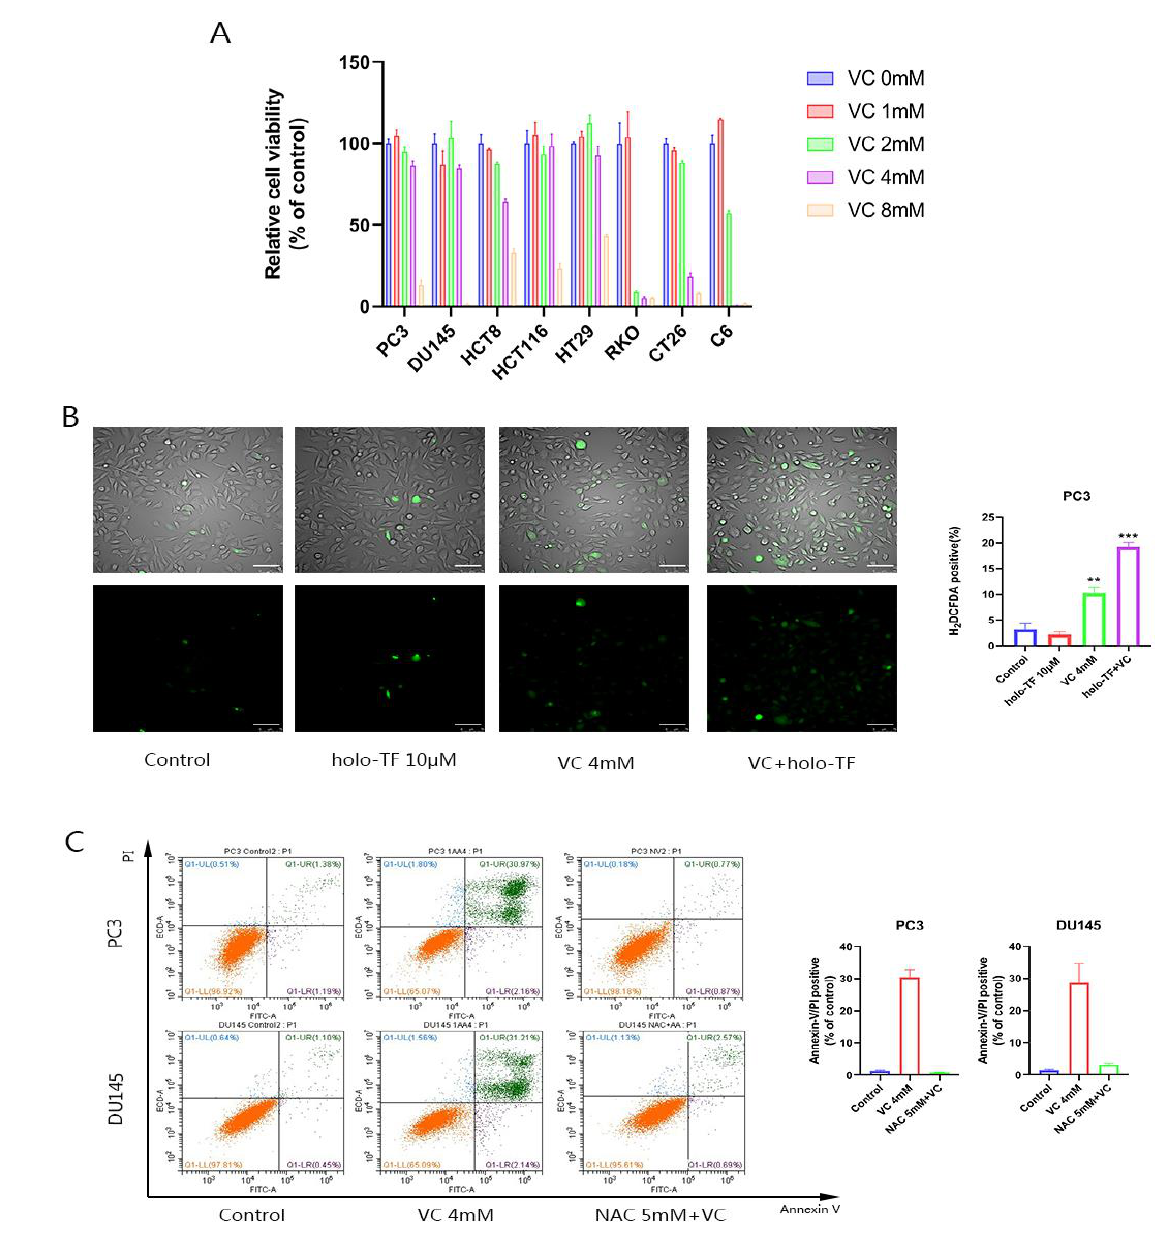
Figure 1. High-dose VC inhibits the proliferation of eight kinds of cancer cells, which are mediated by ROS generation. ( A ) Relative cell viability of eight kinds of cancer cells after different doses of VC treatment for 6 h. ( B ) Merge photos of ROS production after 4 mM VC and/or 10 μM holo -TF treatment for 30 min in PC3. The ROS production was assessed using fluorescence microscopy. Scale bars: 100 μm. ( C ) PC3 and DU145 cell apoptosis evaluated by an annexin-V/PI assay after treatment with 4 mM VC for 16 h alone and/or pretreatment with 5 mM NAC for 1 h, and then with VC treatment. ** p < 0.01, *** p < 0.001.